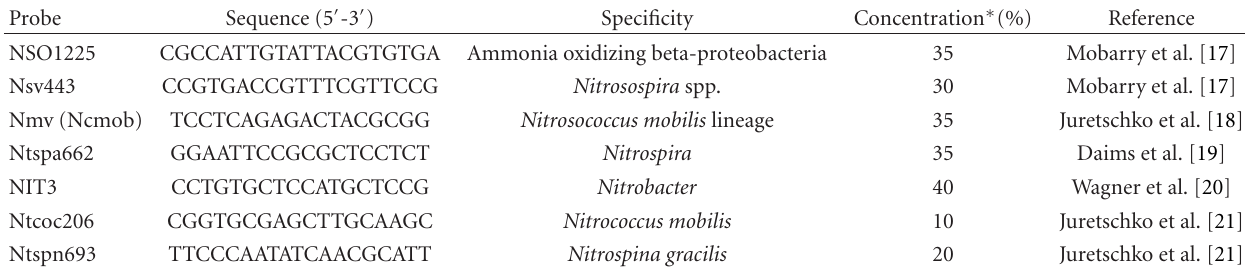
Table 1: List of 16S rRNA-targeted oligonucleotide probes used in the study.